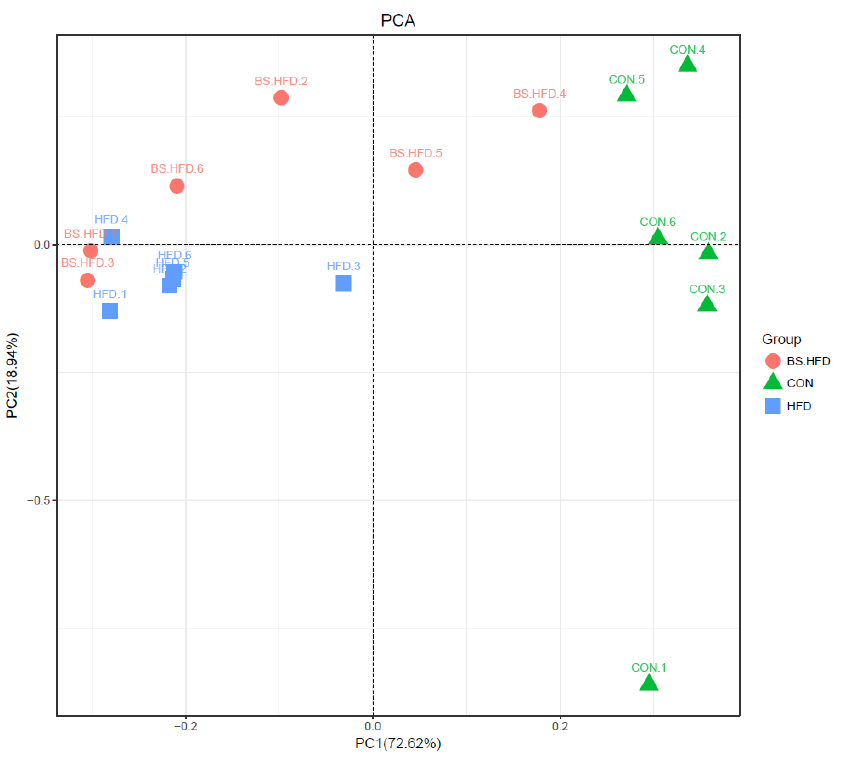
Figure 4. PCA analysis of intestinal microbiota Beta diversity in C. idella .